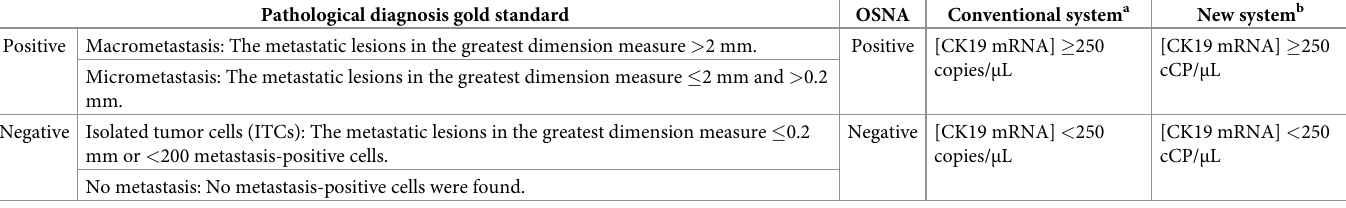
Table 1. Diagnostic characteristics of histopathology, conventional system, and new system. Pathological diagnosis gold